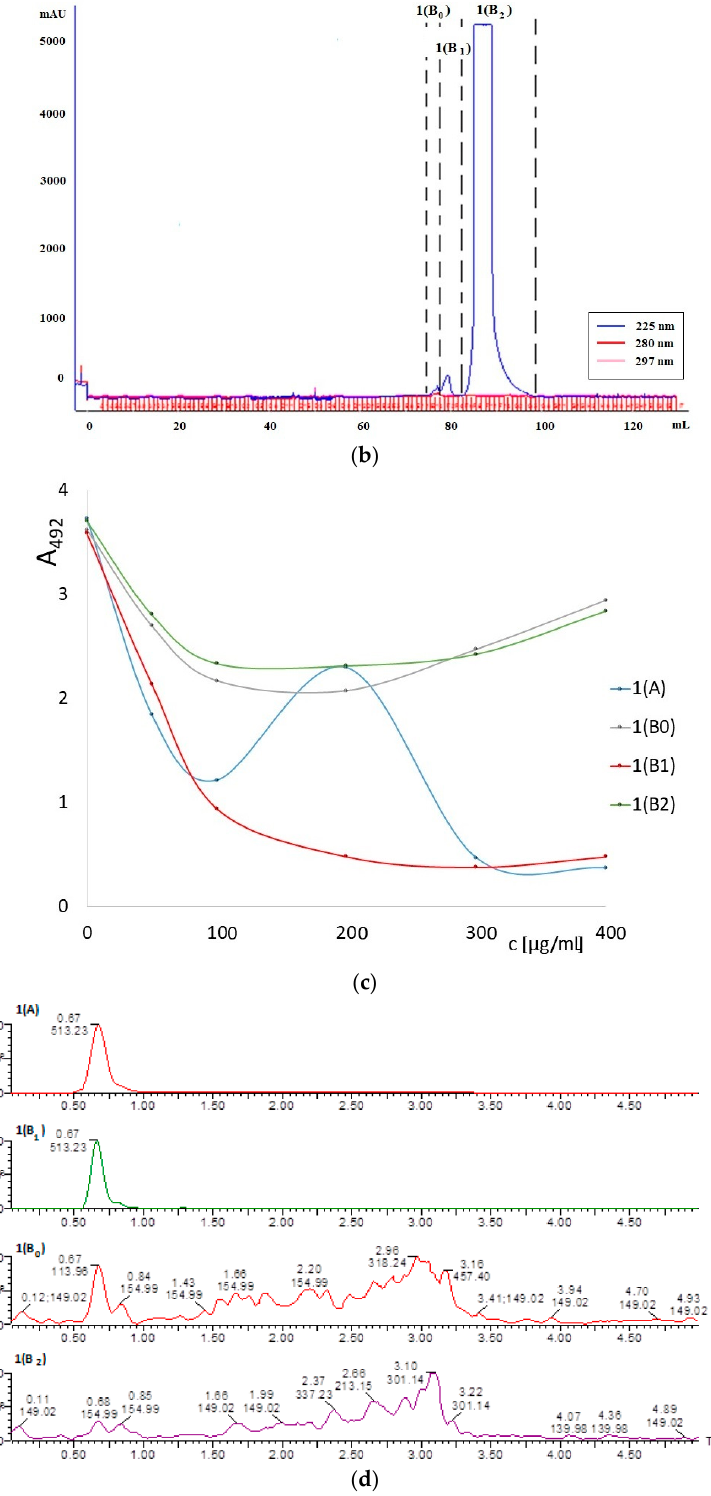
Figure 3. Purification and characterization of low molecular weight glycation products obtained in the synthesis of N-acetyl lysine with melibiose (NAc α Lys-MEL) in a microwave reactor: ( a ) The elution profile of NAc α Lys-MEL separated by FPLC chromatography (HW40-S column); ( b ) elution profile of “1(B)” peak separated by FPLC chromatography (Bio-Gel P-2 column); ( c ) effectiveness of NAc α Lys-MEL fractions 1(A), 1(B0), 1(B1) and 1(B2) in inhibiting MAGE/anti-MAGE reaction; ( d ) mass chromatograms for ion 513.23 m / z for NAc α Lys-MEL peaks 1(A), 1(B0), 1(B1) and